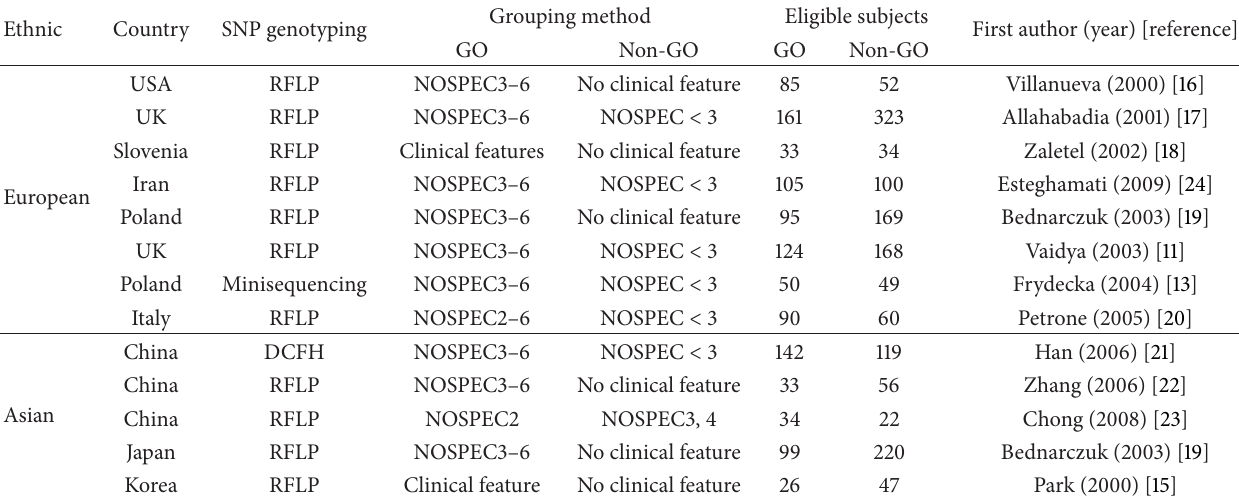
Table 1: General characteristics of the selected studies in the